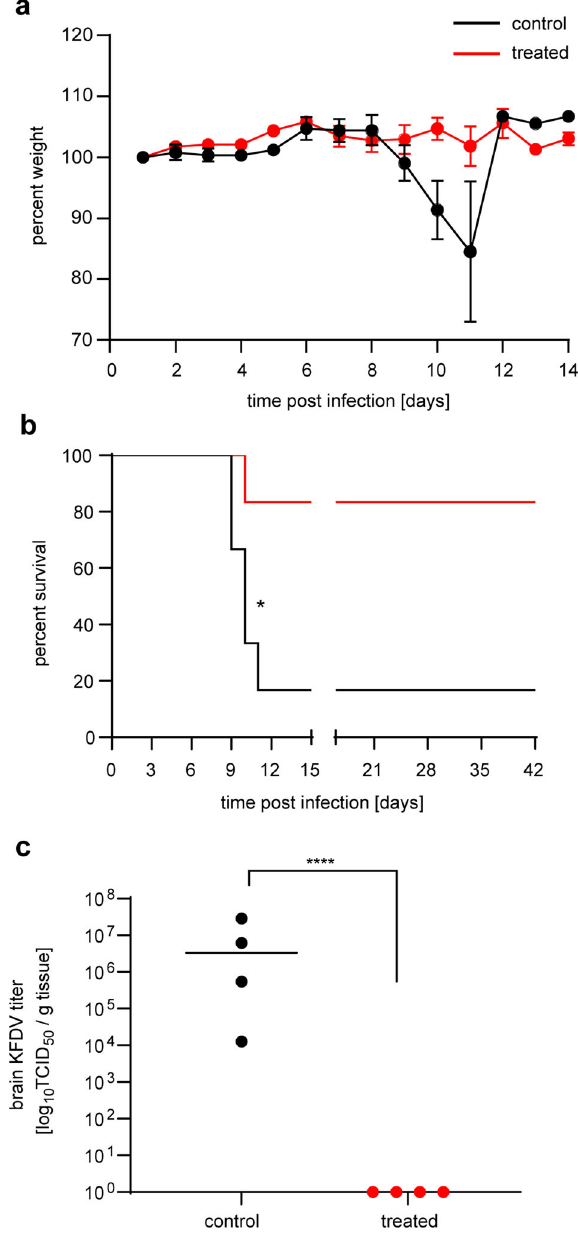
Fig. 6 Passive transfer of hyperimmune plasma protects mice against lethal KFDV challenge. Female BALB/c mice ( n = 10 per group) were treated intraperitoneally (IP) with 500 µl of pooled plasma from mice that were immunized prime/boost with either VSV-EBOV or VSV-KFDV1. Twenty-four hours after treatment, all mice were challenged IP with 100 LD 50 (1 PFU) of KFDV. On 8 dpi, 4 mice from each group were euthanized for sample collection. Surviving mice were monitored until 42 dpi. The KFDV-prM-E IgG titer of the pooled plasma used for treatment was determined to be 3 log 10 . a Weight curve. b Survival curve. c KFDV load in brain tissue. Error bars represent the standard deviation. Statistical signi fi cance for survival curves and brain titers were analyzed using the Mantel – Cox test and the unpaired T tests in prism 7 (GraphPad), respectively. Results are indicated as * p < 0.05 and **** p < MA) 64 (Fig. 1a). Viral recovery was performed via co-transfection of BHK-T7 cells and subsequent blind passage of the supernatant onto VeroE6 cells as previously described 38 . RNA was extracted from the culture supernatant using the QIAmp viral RNA extraction kit (Qiagen, Germantown, MD). The